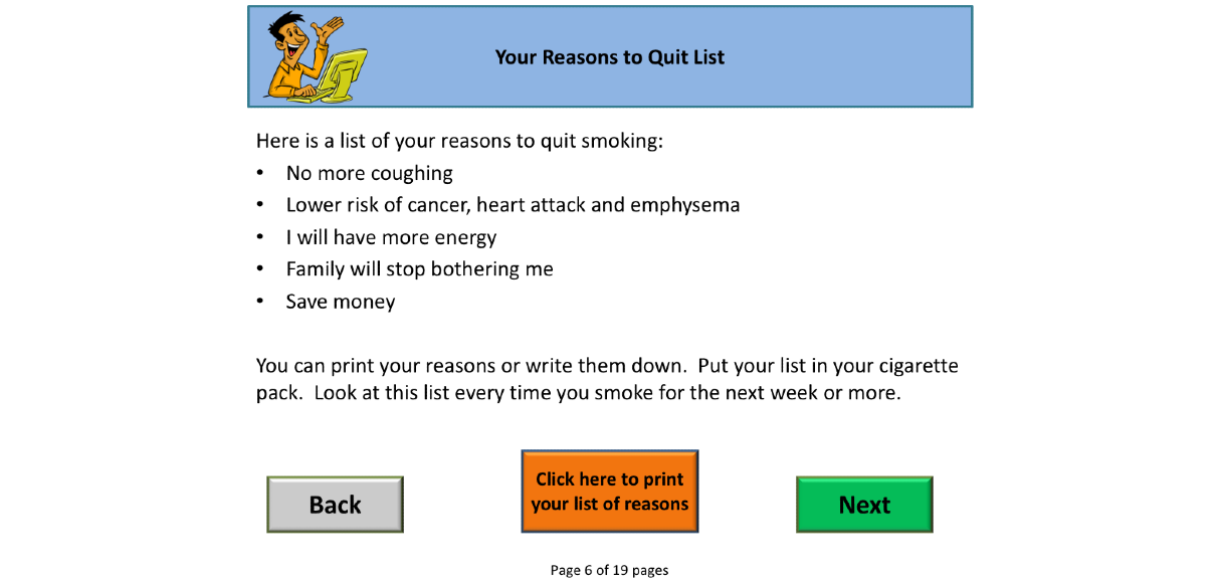
Figure 2. Feedback screen from the smoking cessation decision support tool, “Let’s Talk About